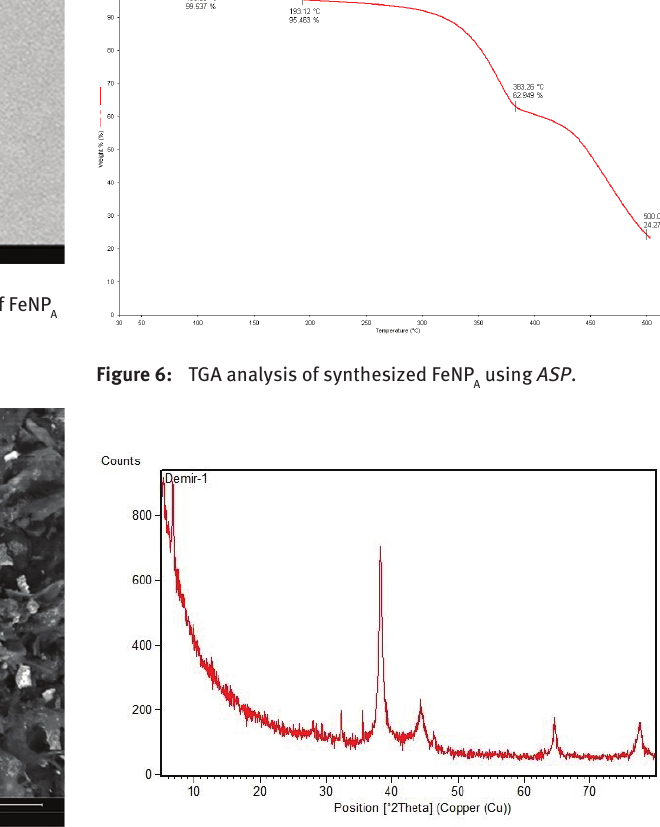
Figure 4: Scanning electron microscopy (SEM) images of FeNP synthesized by ASP .